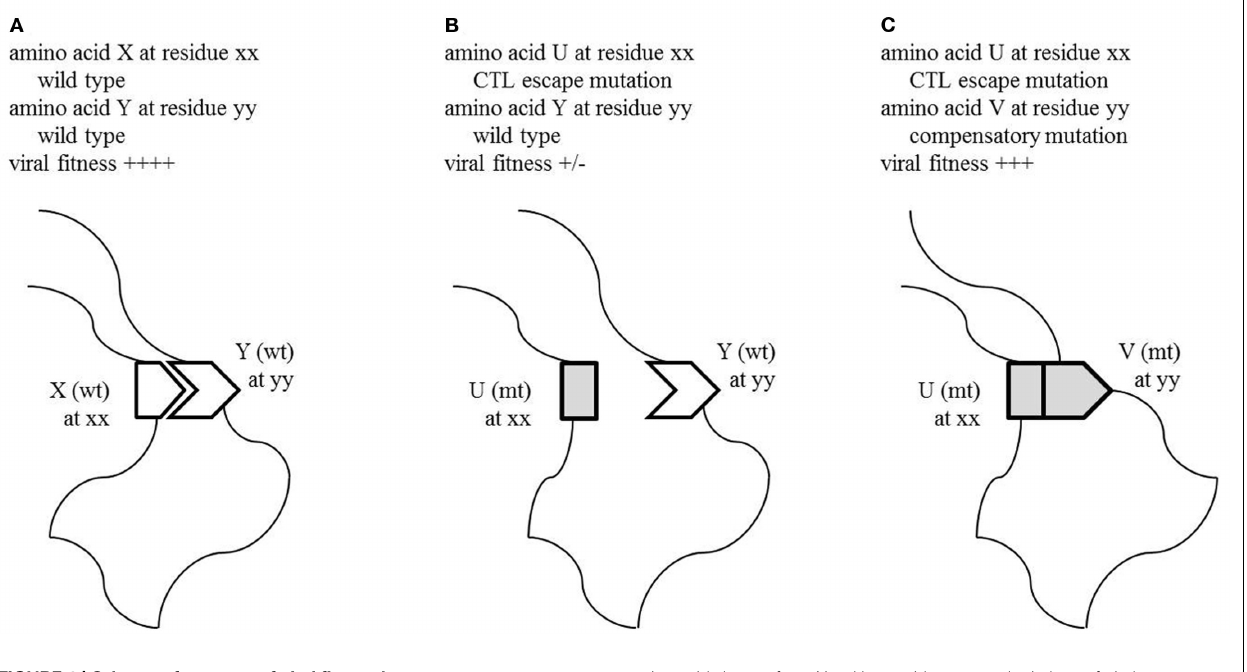
amino acid change from X to U at residue xx results in loss of viral fitness. (C) An additional compensatory mutation leading to an amino acid change fromY toV partially or fully restores viral function and